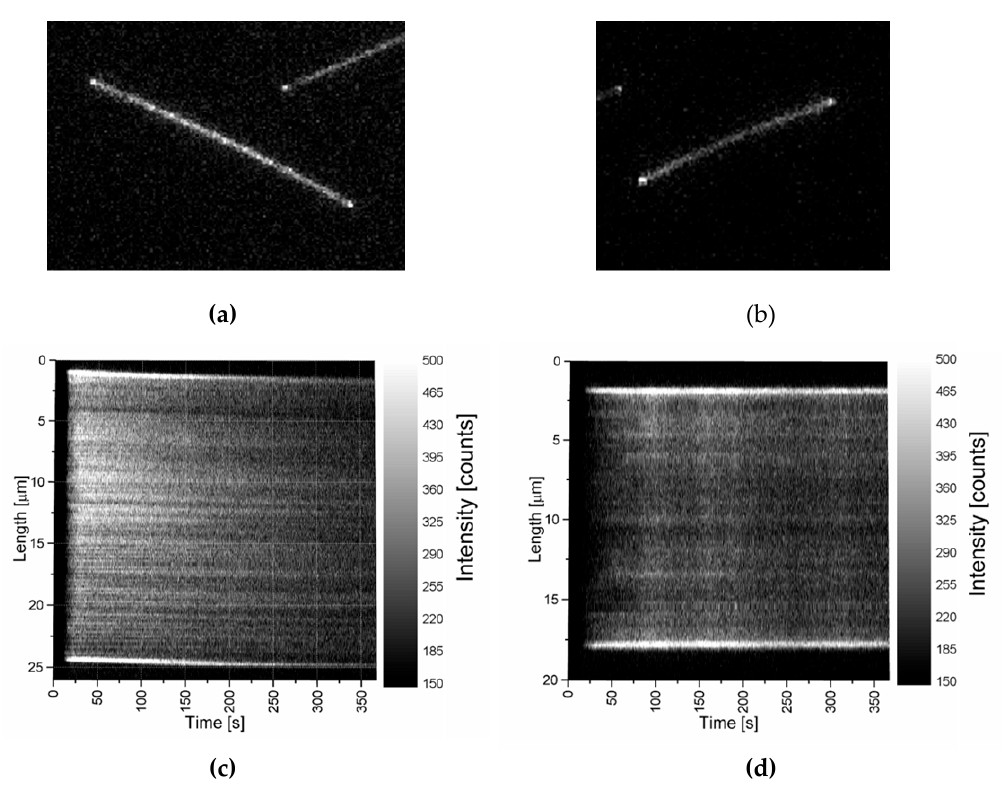
Figure 9. Temporal evolution of fluorescence for a single nanowire covered with a solution of PCP complexes. The nanowire on a glass substrate is shown in the left column, while the right column shown the results obtained for the nanowires deposited on a streptavidin-coated glass substrate. Images of fluorescence for proteins attached to silver nanowires are shown in ( a ) and ( b ), respectively, while the evolutions of fluorescence are displayed in ( c ) and ( d ), respectively.